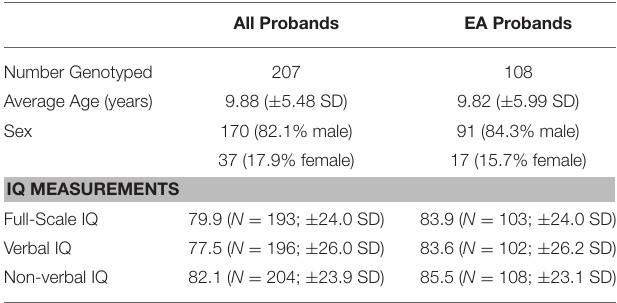
TABLE 1 | Demographic description of the entire genotyped sample and the genotyped European Ancestry (EA)